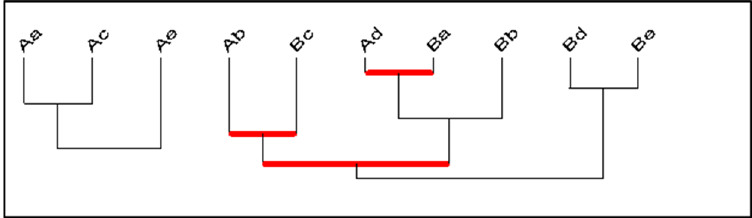
Figure 5. Similarity graph for didactic variables Type A (student´s solution to Task A) and Type B (student´s solution to Task B).